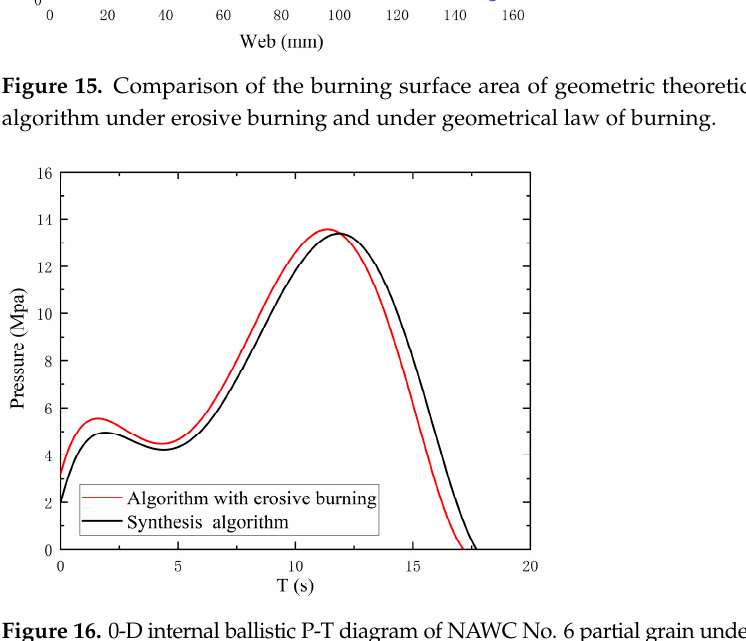
Figure 16. 0-D internal ballistic P-T diagram of NAWC No. 6 partial grain under the synthesis algo- rithm.